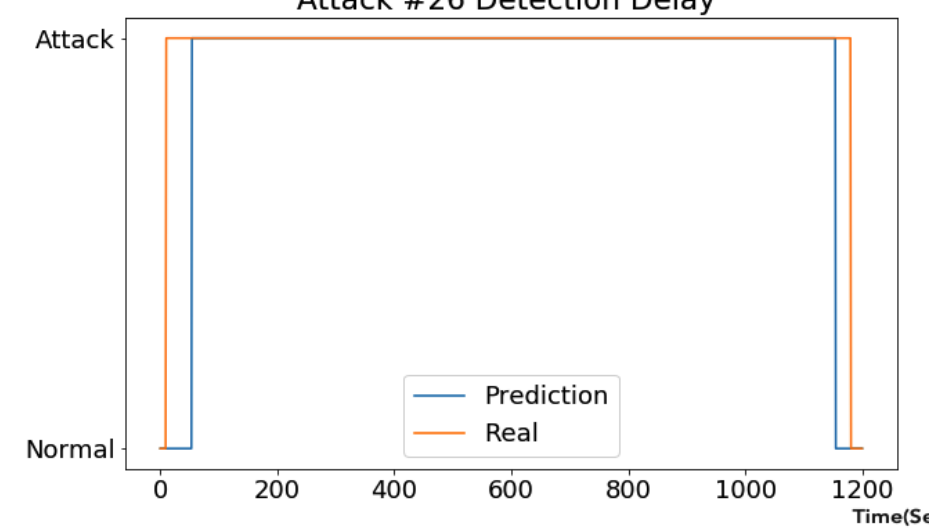
Figure 8. Example of an attack detection by the CNN + LSTM model for attack #26 ( see Table